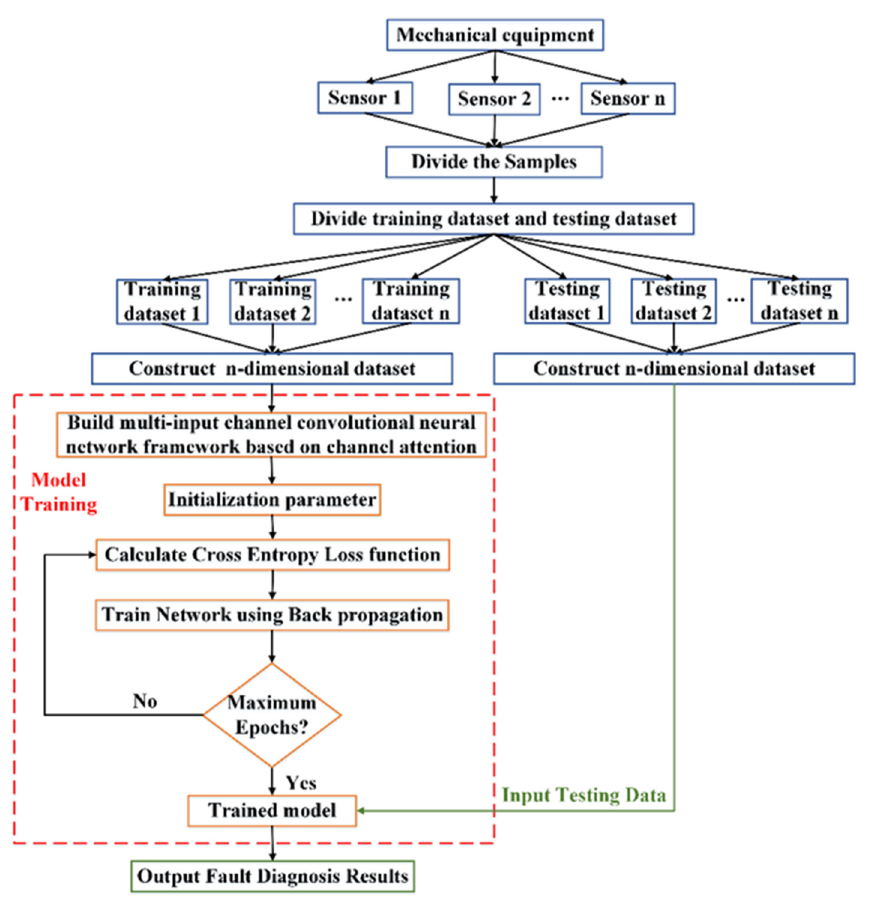
Figure 3. F lowchart of the proposed method. Figure 3. Flowchart of the proposed